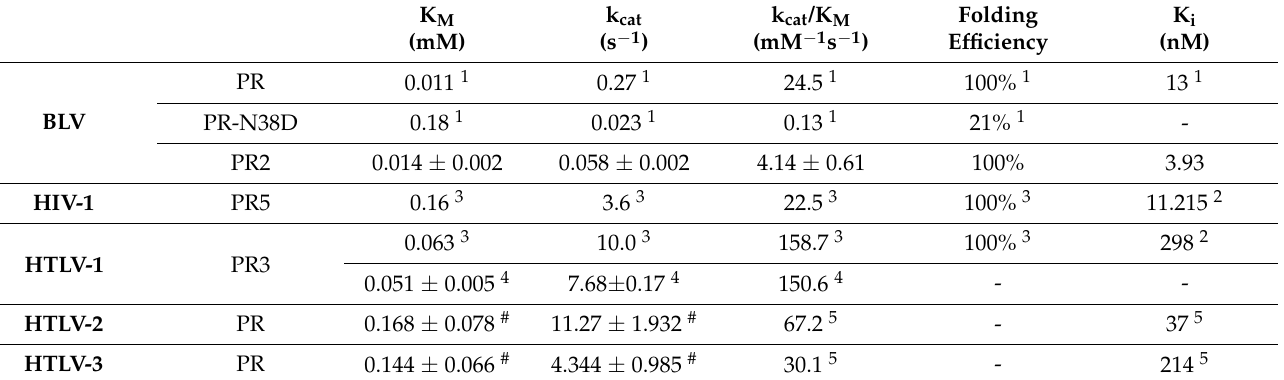
Table 3. Comparison of the catalytic properties and folding efficiencies. The kinetic parameters and folding efficiencies are shown for HIV-1, BLV and HTLV PRs. For kinetic analysis of MBP-fused BLV PR2, we used oligopeptide substrate representing HTLV-1 CA/NC cleavage site. Average values are shown based on the results of two independent experiments, the errors are indicative and represent differences between the obtained values. For comparison, literature data are also shown: the values for the wild-type and N38D mutant BLV PRs 1 [33], and for HTLV and HIV-1 PRs were determined previously 2 [55] 3 [54] 4 [37] 5 [35]. # The K M and k cat values were also determined previously by Kassay et al. [35] but have not been published to date. K M k cat (mM) (s − 1